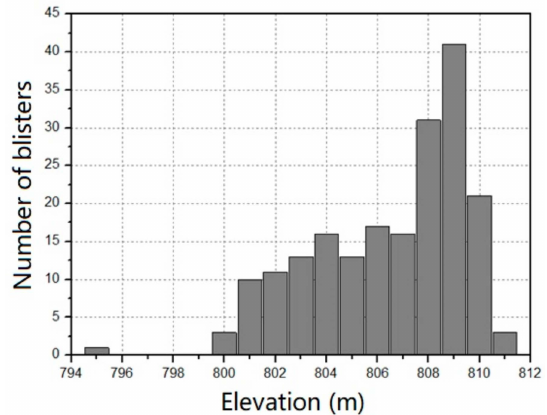
Figure 2. Blisters along the elevation distribution.